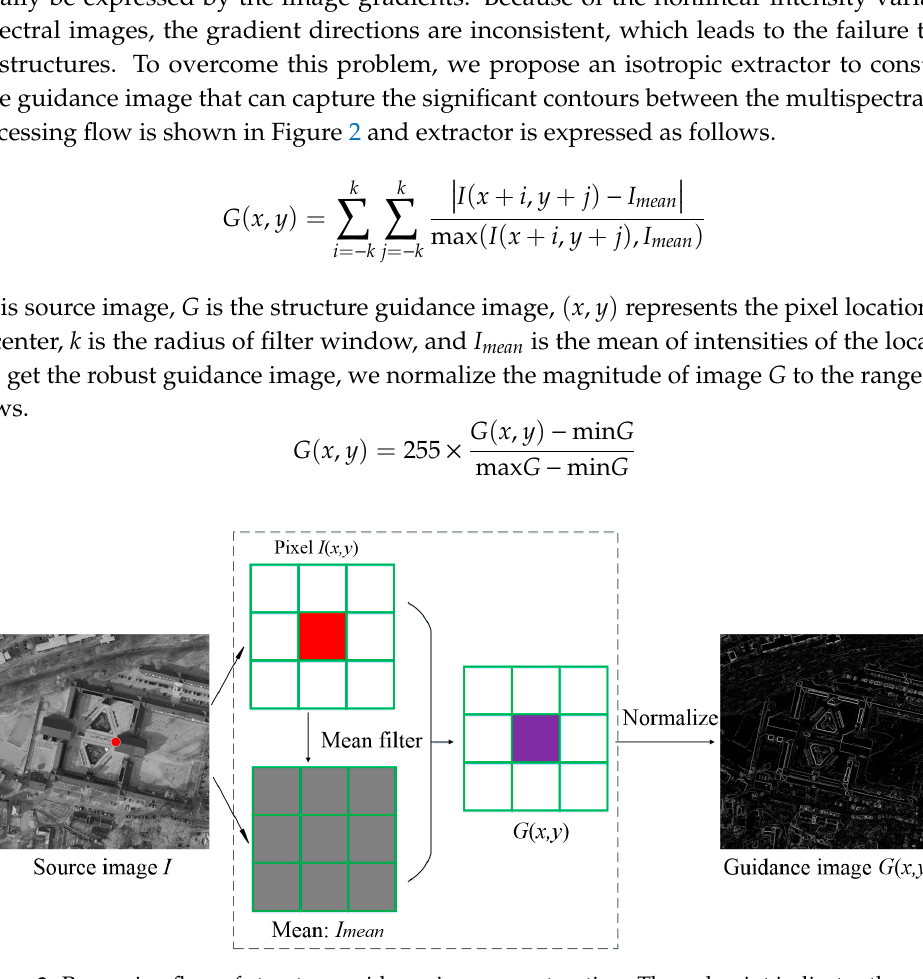
Figure 2. Processing flow of structure guidance image construction. The red point indicates the center pixel of the local region.